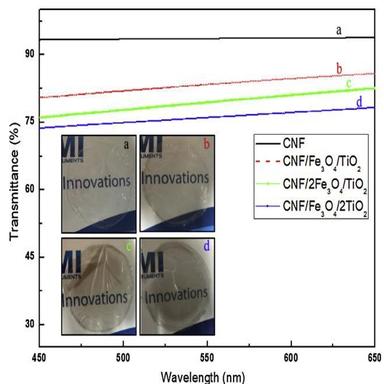
UV–vis transmittance spectra of the CNF and its composite nanopapers. The insets show the photos of these composite nanopapers.